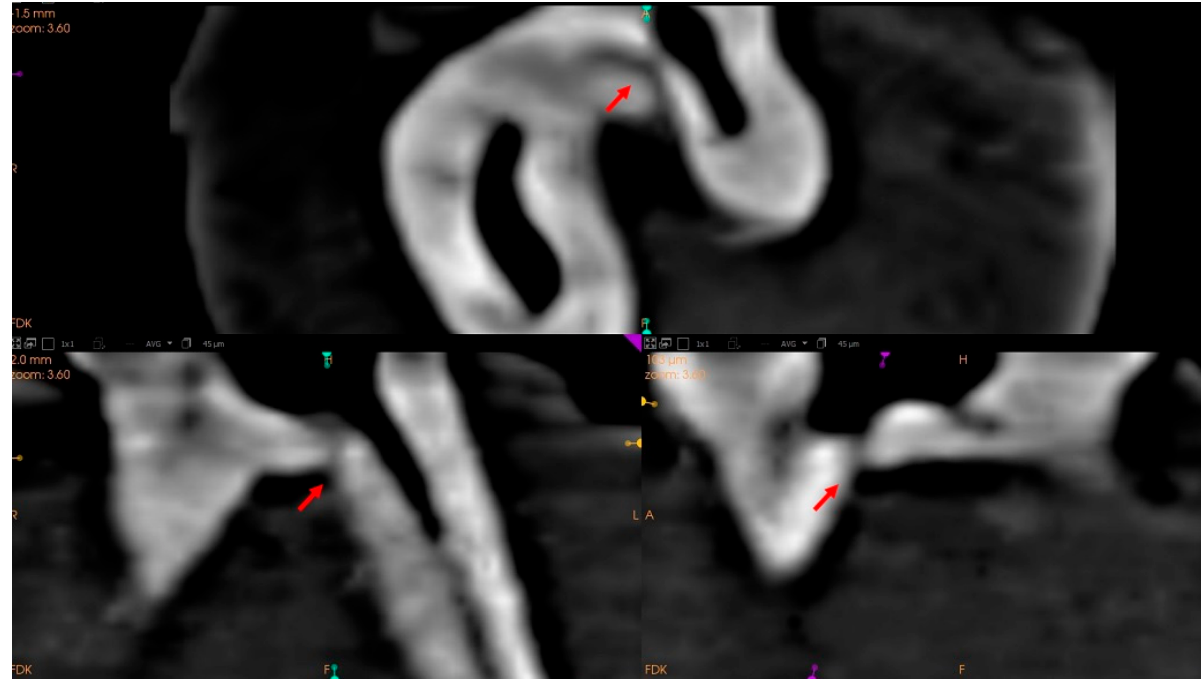
Figure 5. Tomographic views of the pulp chamber floor. Arrows point to hypodense images compati- ble with accessory canals. Axial view ( a ); coronal view ( b ); and sagittal view ( c ).